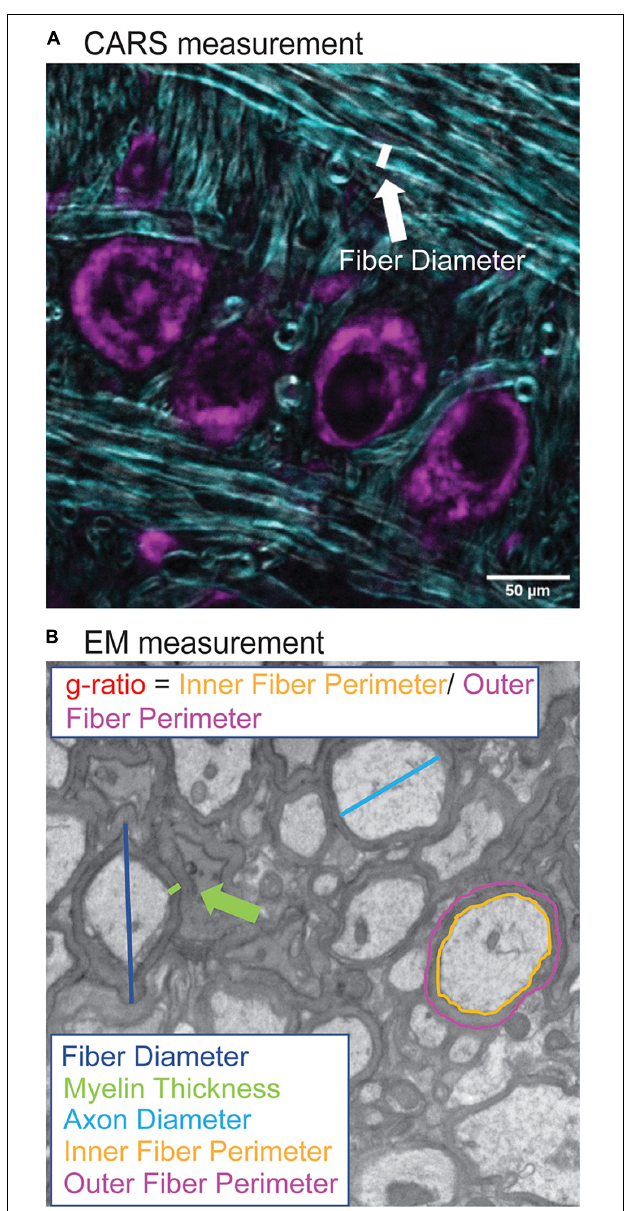
FIGURE 2 | Quantification of myelination morphology in CARS and EM images. CARS images were quantified using the FIJI line segment tool. A line, as indicated by white line (A) , was drawn and the measure function used to measure the fiber diameter for 20 axons per image (purple indicates cell bodies stained with Nissl, CARS signal in cyan). For EM images, increased resolution allowed for more detailed analysis including fiber diameter (dark blue), axon diameter (cyan), myelin thickness (green), inner (orange) and outer (purple) fiber diameter (B) . Inner and outer fiber perimeter were then used to calculate g-ratio, which is the inner fiber diameter/outer fiber